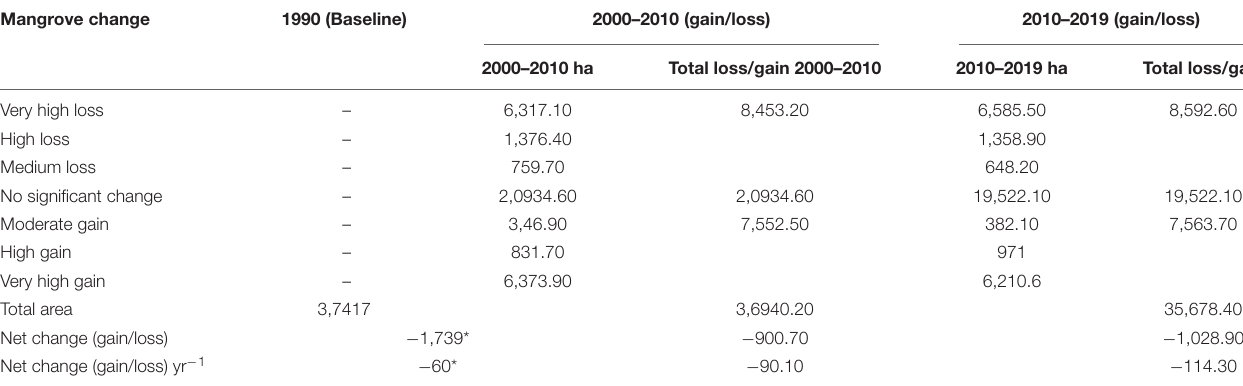
TABLE 3 | Lamu mangrove cover and cover change over the 2000–2019 period. Mangrove